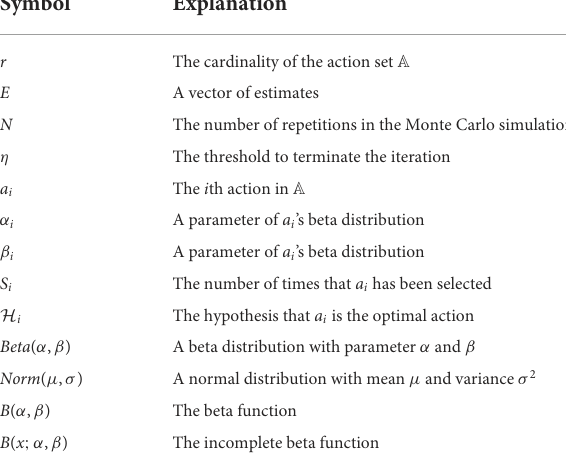
TABLE 1 Notations used in this